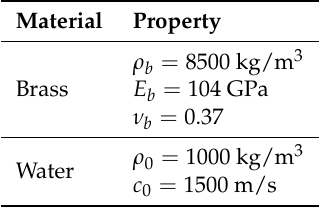
Figure 4. Scheme of the finite element method (FEM) model. Table 1. Acoustic properties used in FEM simulations.